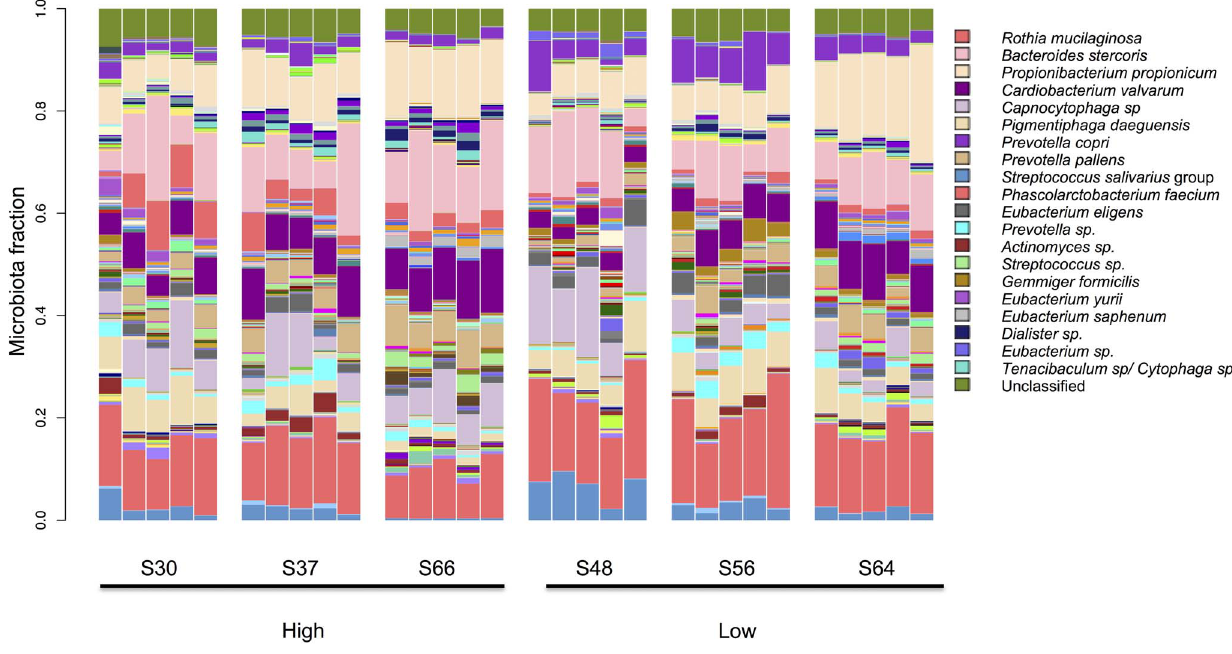
Figure 4. Each bar represents a single saliva sample and each cluster of bars is a single participant (starting at time 0 and sampled once a week for up to 4 weeks total). The colored segments represent the relative fraction of each bacterial taxon detected at 1% relative abundance or greater (twenty most predominant OTU shown). Sequences at less than 1% abundance have been included in the ‘‘remainder’’ fraction at the top of the bar (see color legend of bacterial taxa).